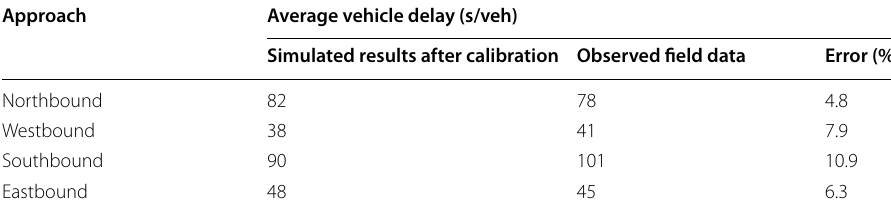
Table 2 Comparison of average vehicle delay for calibration model with field data Approach